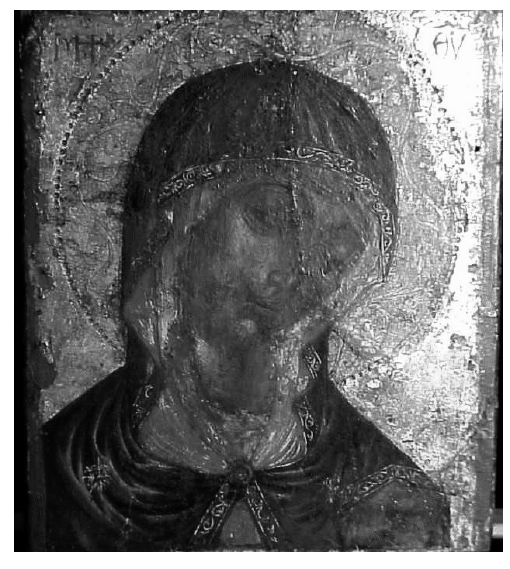
Fig. 15. The Byzantine icon (century XVII).